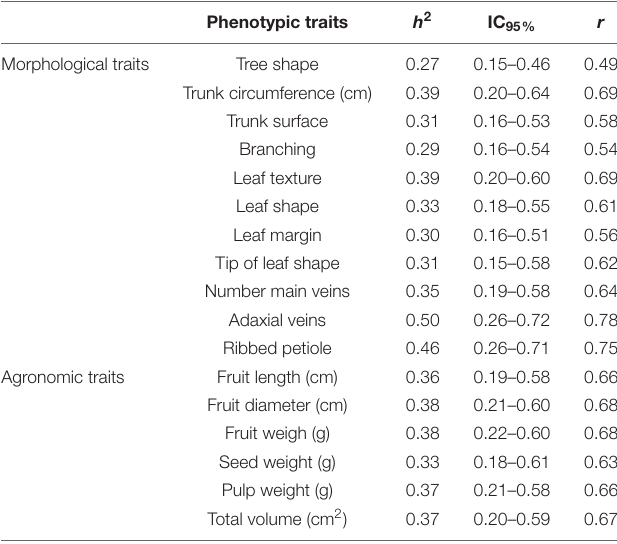
TABLE 2 | Narrow—Sense heritability ( h 2 ) estimates for the 17 measured traits from 82 avocado “criollo” “plus trees” selected as seed donors for rootstocks. Phenotypic traits h